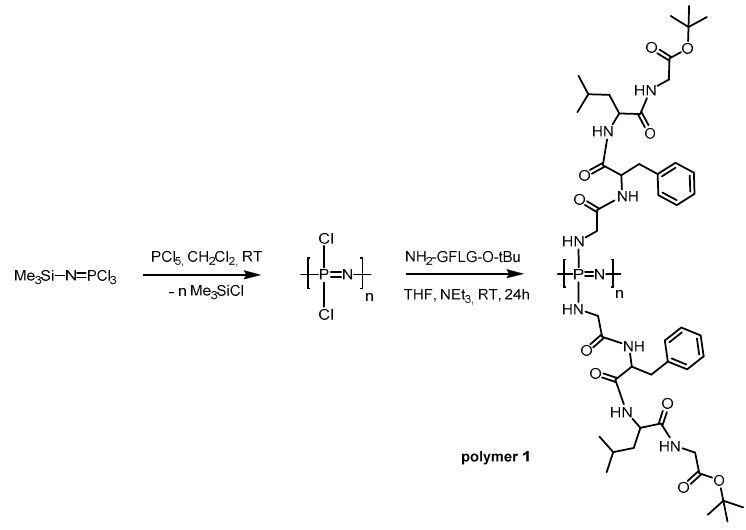
Figure 1 . Living polymerisation of poly(dichlorophosphazene) and macromolecular substitution of the chlorine atoms by Gly-Phe-Leu-Gly-OtBu. Polymers 2016 , 8 , 161 Table 1. Structural data for polymers 1 – 5 .